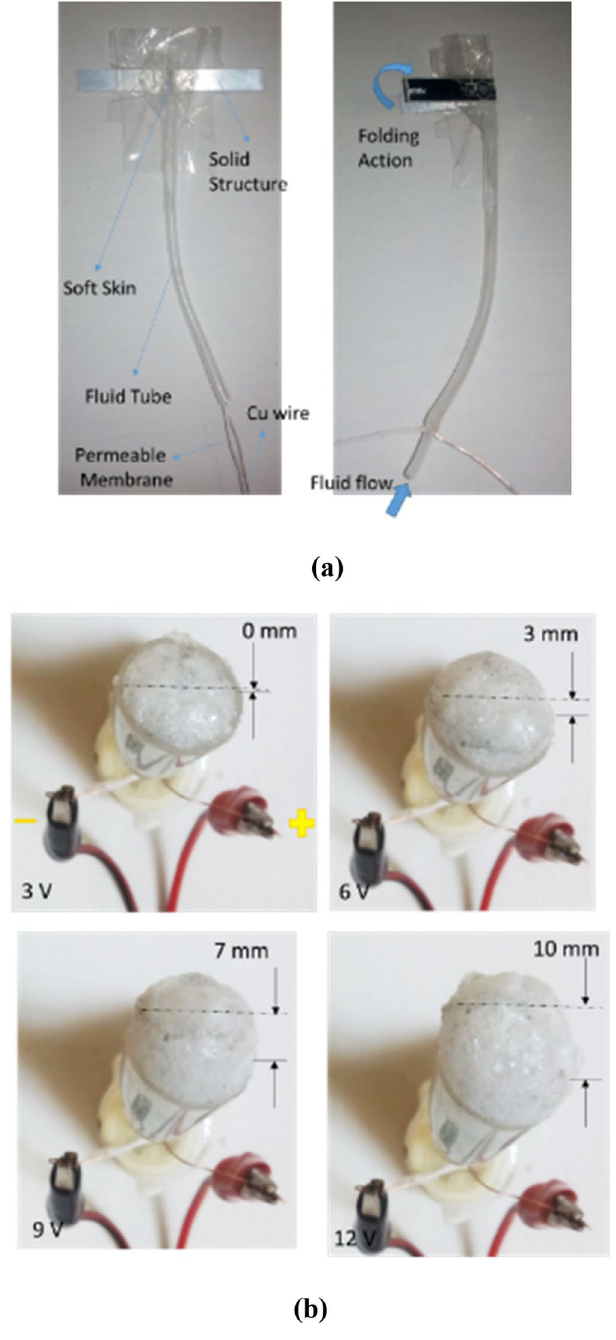
Figure 3. Mixed integration electrolysis module. Fabrication of single soft skin-solid structure with mixed integration electrolysis module (a) , chemical reaction of electrolysis through electrolyte in different voltages (b)